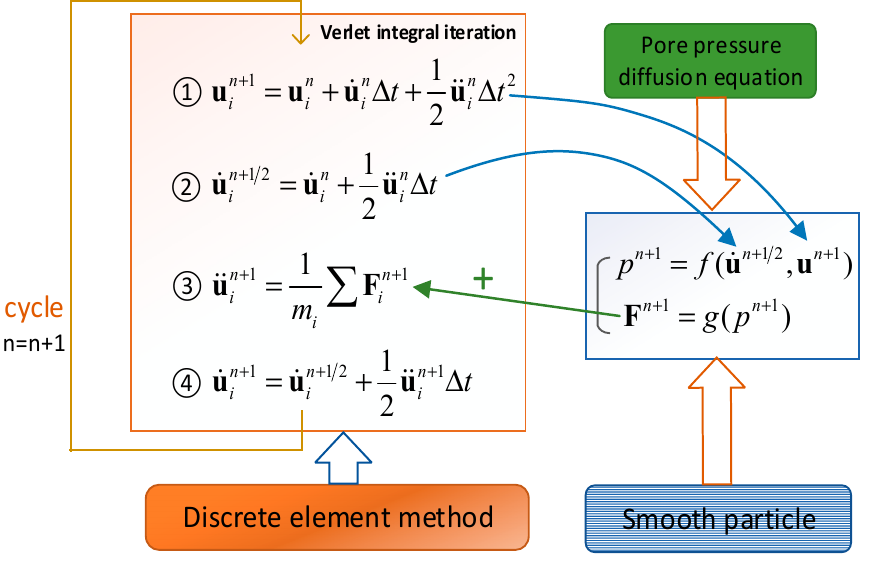
Figure 4. Flowchart of the coupling in DEM-SP.